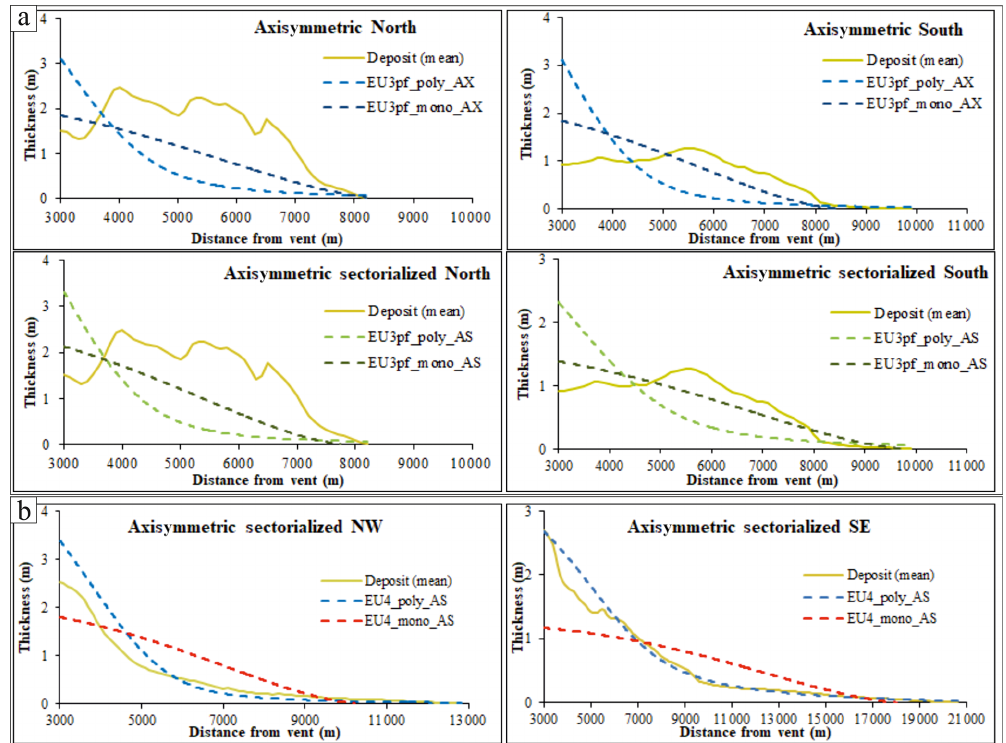
Figure 6. Mean thickness comparison between the simulations (dashed lines) and the actual deposit (solid line) of (a) EU3pf and (b) EU4b/c units. Different boxes concern different circular